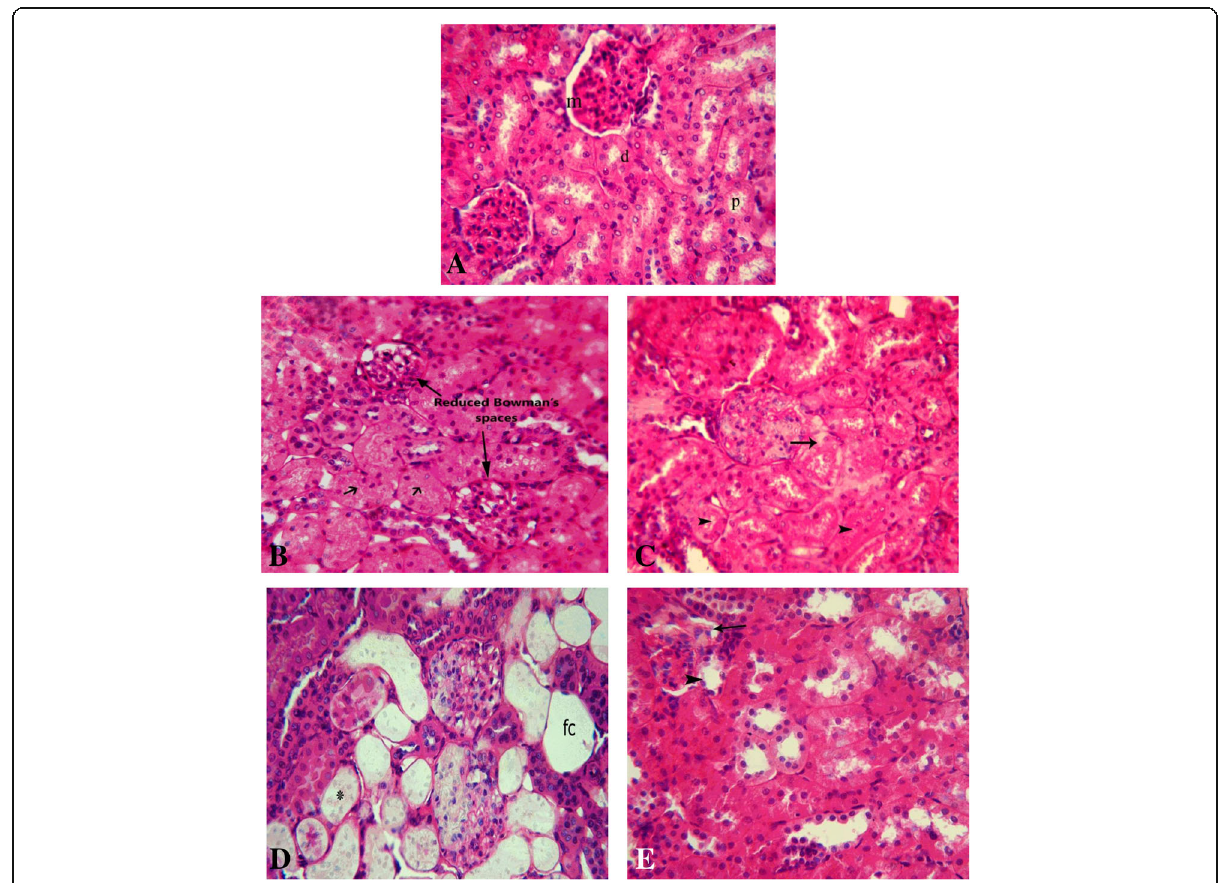
Fig 2 Photomicrographs of kidney hematoxylin and eosin cross sections. a Section of control group showing the kidney cortical tissue with Malpighian corpuscles (m), proximal (p), and distal (d) tubules. b Section of the kidney in CA group showing hypertrophy in the Malpighian corpuscles with reduced Bowman ’ s spaces, adhesions between the glomerular tuft and Bowman ’ s capsule (long arrows), renal tubular degeneration is characterized by rupture of the apical surface of tubule cells and necrotic nuclei (short arrows). c The section in CA group showing epithelial vacuolation of renal tubules (arrow) and obliterated lumen (arrowheads). d The section in CA group showing some renal tubular epithelial cells with a marked highly hydropic change (asterisks) and other with fatty change (fc). e Section of CA + FU group showing less or no changes in comparison with CA group, a degenerated glomerulus (arrow), and degenerated tubule (arrowhead) are noticed. (H&E ×